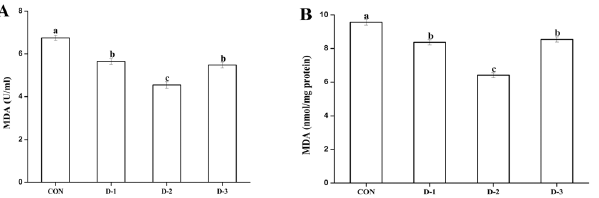
Fig 3. Effects of DMG-Na on MDA concentrations in mice serum (A) and liver (B). Values are mean ± SEMs (n = 10). Mean of a variable without a common letter differ, P < 0.05. Malondialdehyde (MDA). CON, gastric intubation in mice with 0 mg DMG-Na/0.3 ml sterile saline solution; D-1, gastric intubation in mice with 9 mg DMG-Na/0.3 ml sterile saline solution; D-2, gastric intubation in mice with 12 mg DMG-Na/0.3 ml sterile saline solution; D-3, gastric intubation in mice with 15 mg DMG-Na/0.3 ml sterile saline solution.